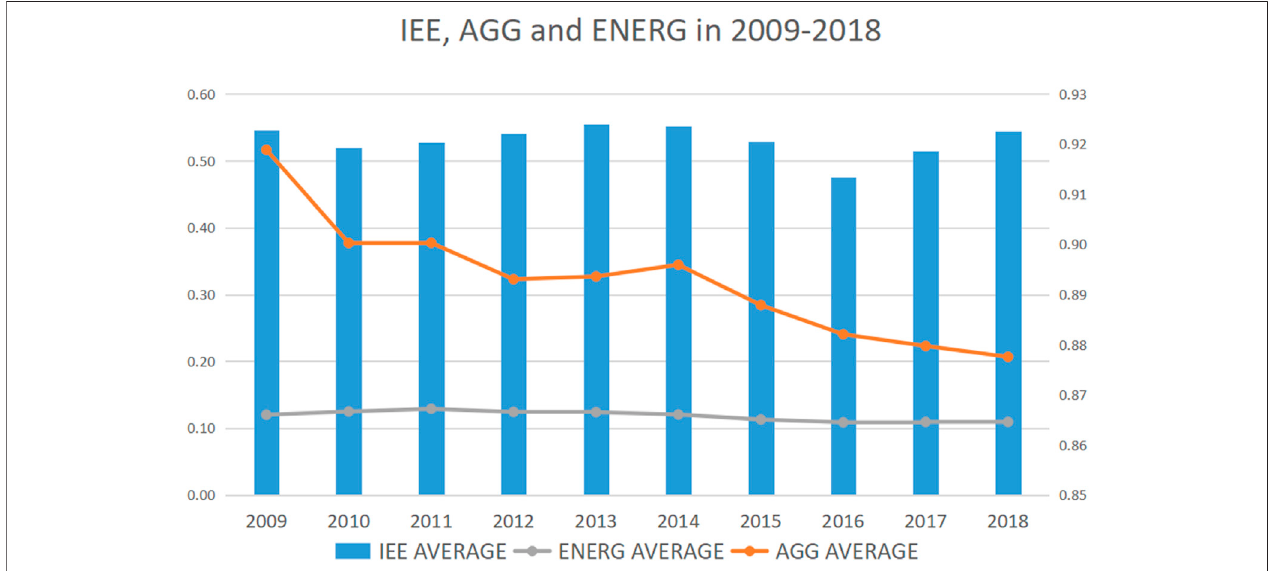
FIGURE 1 | IEE, industrial agglomeration and energy intensity from 2009 – 2018.